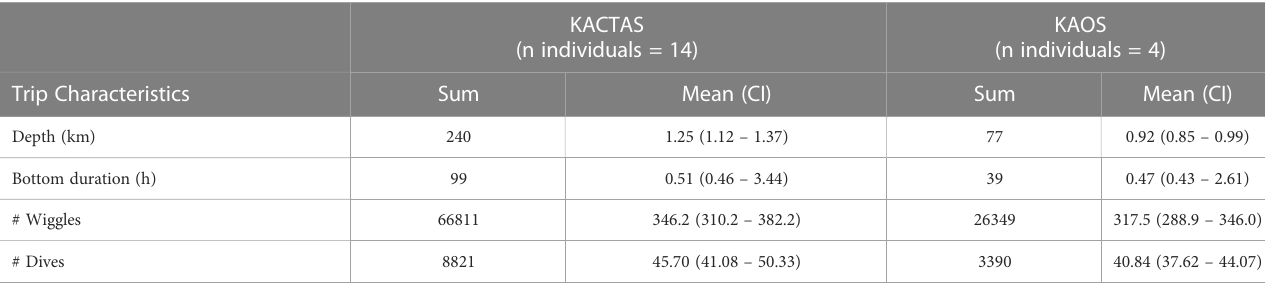
TABLE 3 Summaries of chick-rearing Ade ́ lie penguin activity at Be ́ chervaise Island that occurred over the KACTAS and KAOS survey areas.